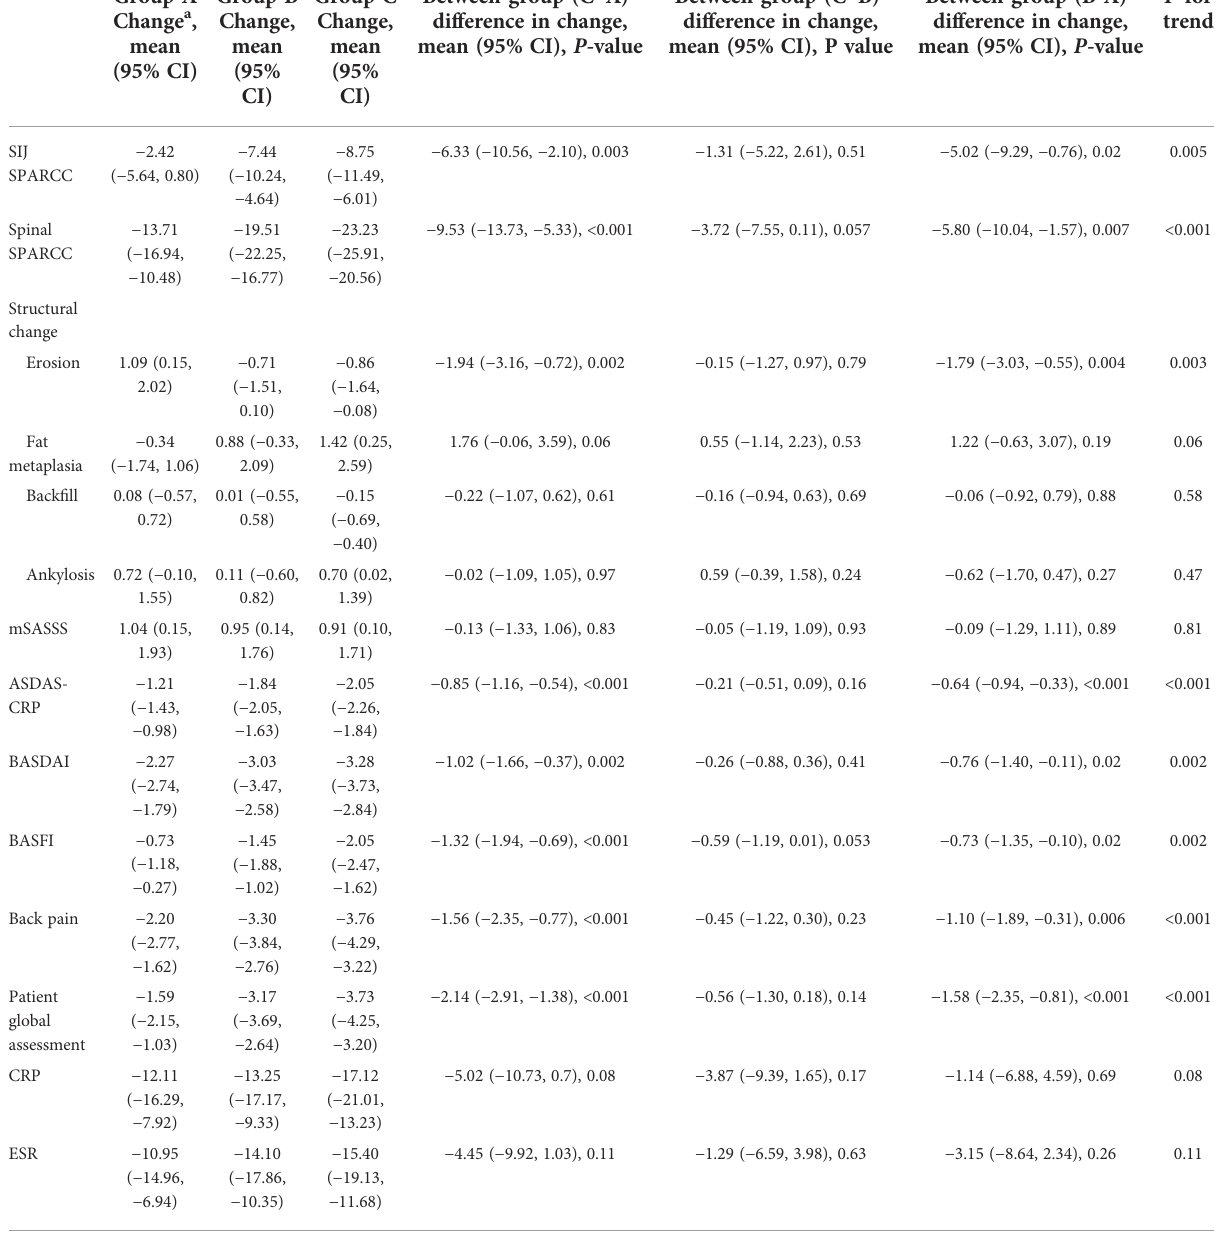
TABLE 2 Associations between treatment groups and changes in outcomes over 52